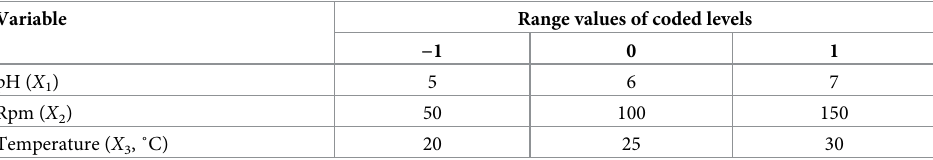
Table 1. Range and corresponding levels of the independent variables. Variable Range values of coded